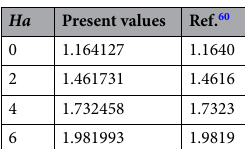
1 ) against magnetic parameter when k −